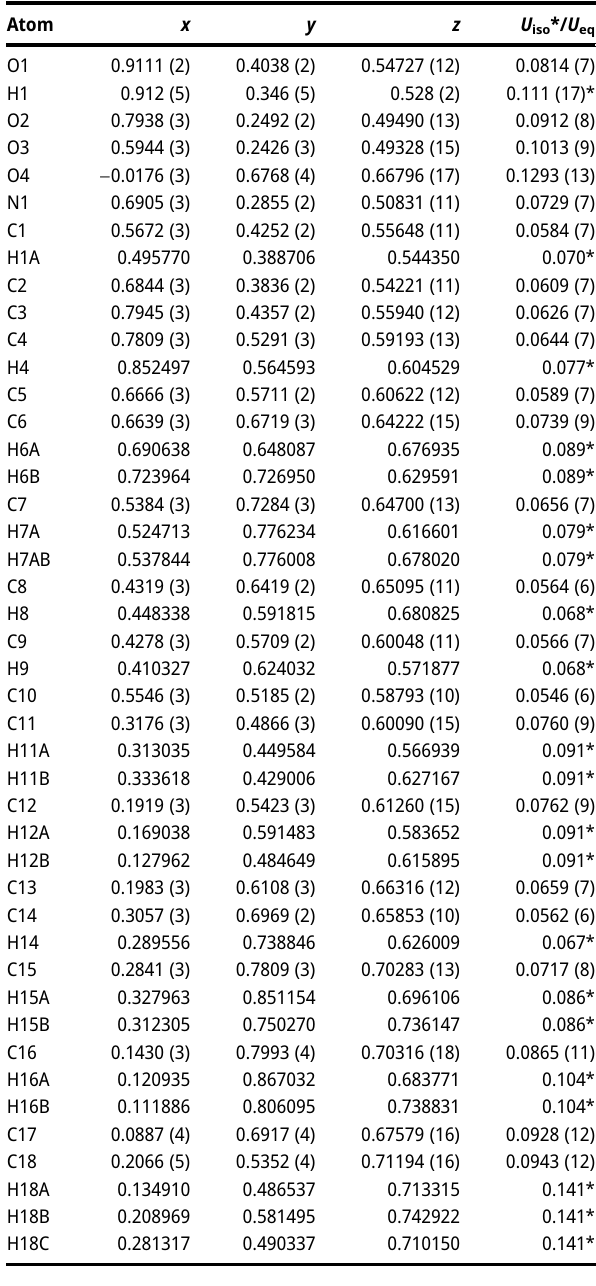
Table  : Fractional atomic coordinates and isotropic or equivalent isotropic displacement parameters (Å 